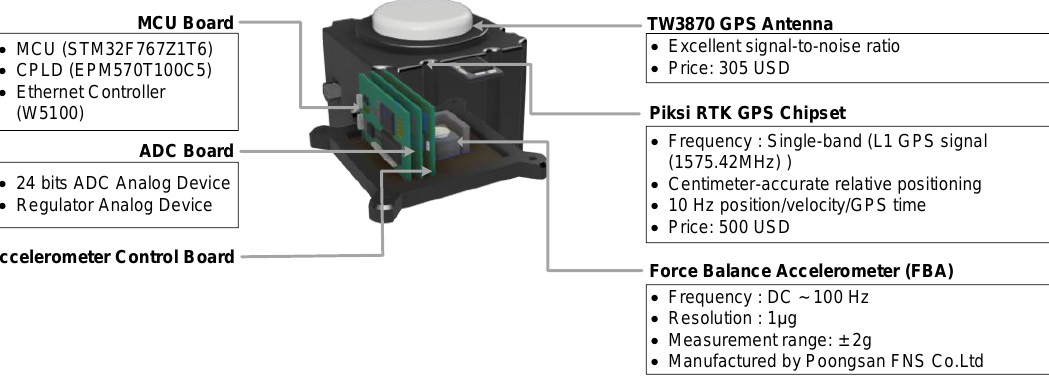
Figure 3. The sensor module composed of a GPS antenna, GPS chipset and a force feedback accelerometer.